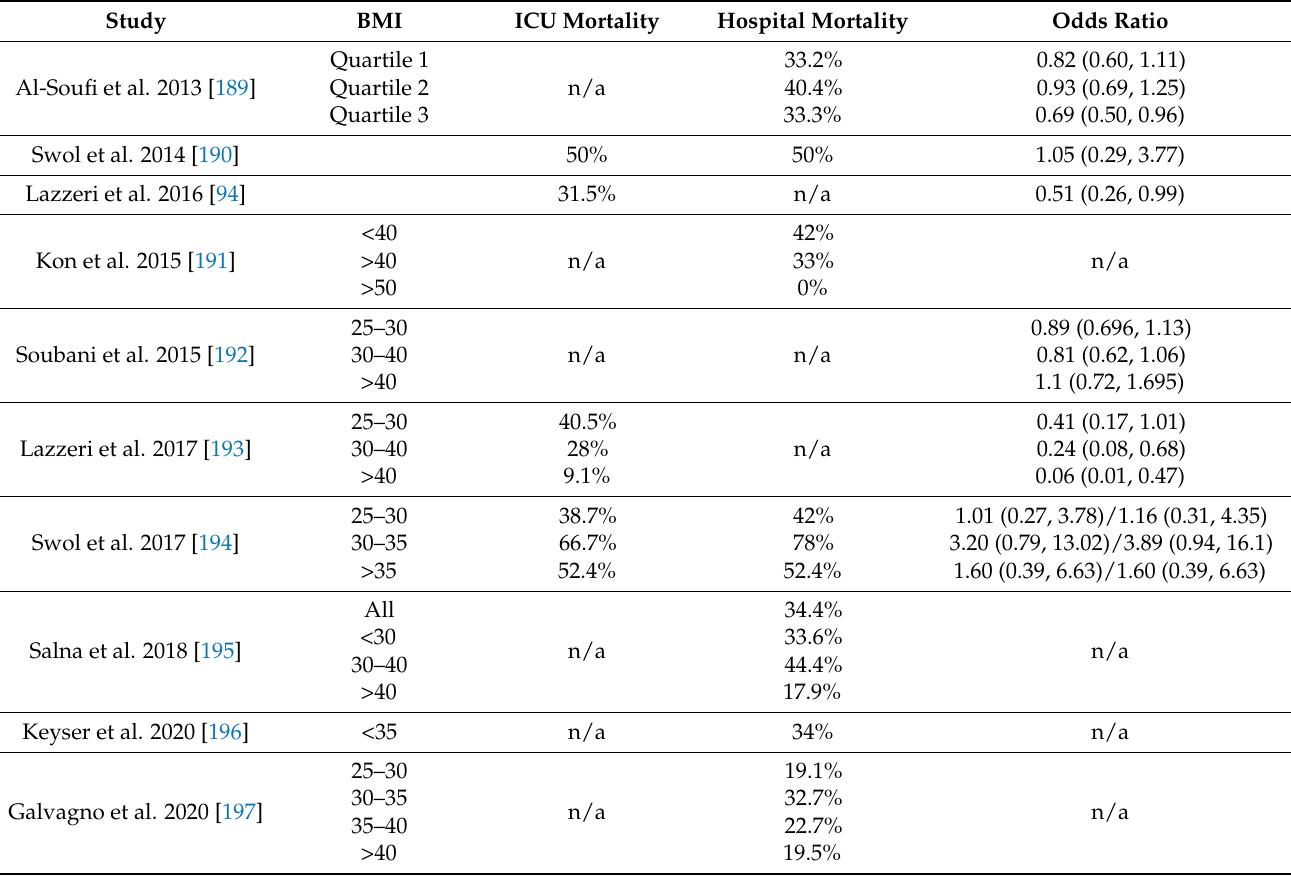
Table 8. Evidence for the use of vvECMO in obese patients and the respective outcome.